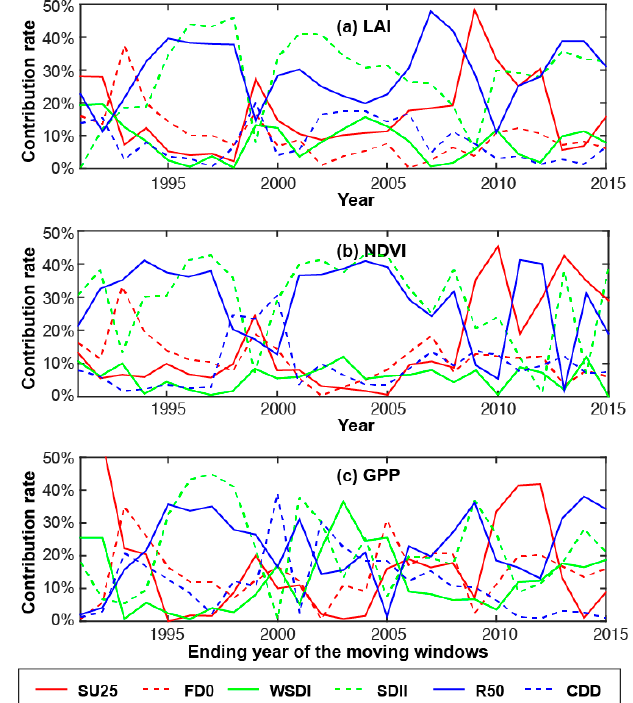
Figure 7. Temporal evolution of the relative contribution rate of the six climate indices to ( a ) LAI, ( b ) NDVI, and ( c ) GPP, respectively. ( b ) NDVI, and ( c ) GPP, Table 5. Relative contribution rates (%) of the six climate indices to ecosystem variables in Hubei Province.